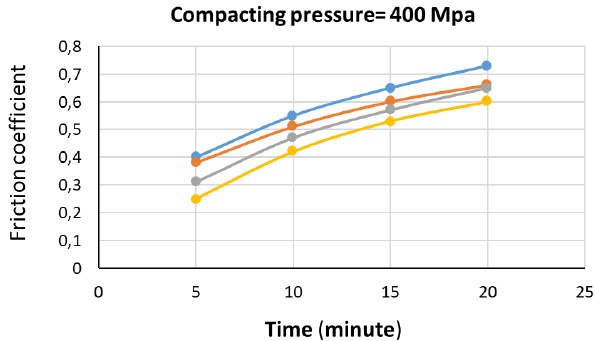
Figure 5: The effect of SiC percentage on the composite’s friction coeflcient over